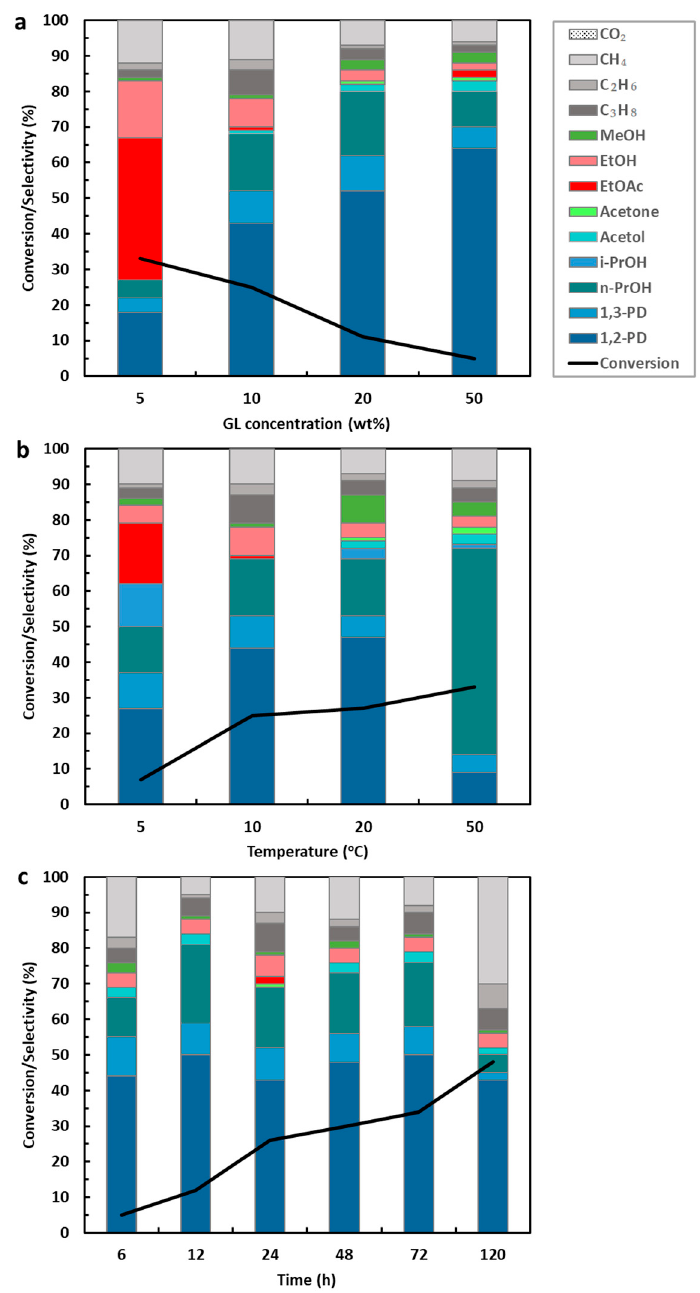
Figure 2. GL conversions and product selectivities with different ( a ) GL concentrations, ( b ) temperatures, and ( c ) reaction times. General reaction conditions: 0.5–5.0 g GL (6–55 mmol) (corresponding to 5–50 wt.%), 0.1 g Ru-WD (0.02 mmol Ru), 10 mL H 2 O, 50 bar H 2 , 150–250 °C, 6–120 h, 1000 rpm.